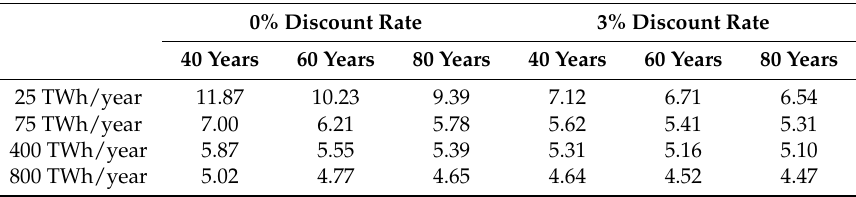
Table 2. LCOE for partial recycling in different scenarios in $(2010)/MWh.